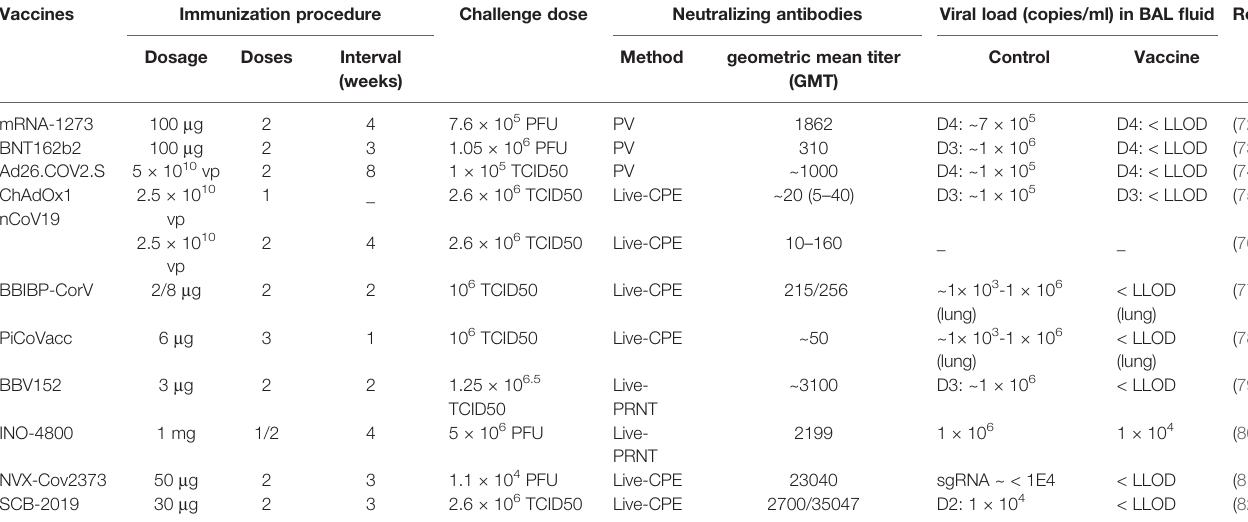
TABLE 2 | Protective effects of neutralizing antibodies in nonhuman primates challenge studies.